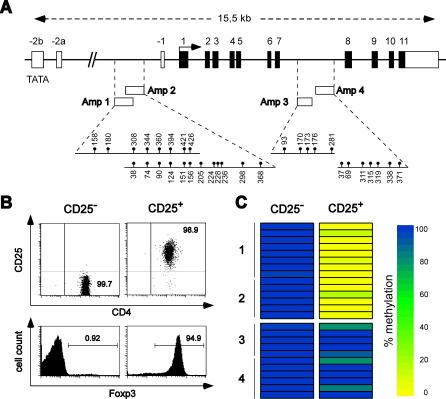
Selectively Demethylated CpG Motifs within the foxp3 Locus in CD25+CD4+ Tregs Isolated from Secondary Lymphoid Organs(A) Schematic view on the foxp3 locus depicts exon-intron structure and position of selected amplicons (Amp 1–4). Shown is the distribution and position of individual CpG motifs within the amplicons.(B) CD25+CD4+ and CD25−CD4+ T cells were sorted from spleens and LNs pooled from 20 male BALB/c mice. FACS analysis shows the sort purity (upper panel) and Foxp3 expression in sorted subsets (lower panel). Numbers display frequency of cells within indicated populations. The bars in the lower graphs indicate the marker gate for Foxp3+ cells. The vertical and horizontal lines in the upper graphs indicate the quadrant used to identify the CD4+CD25+/− subsets.(C) Methylation pattern of selected amplicons of the foxp3 locus in CD25+CD4+ Tregs and conventional CD25−CD4+ T cells. The amplicons are subdivided by horizontal lines each representing an individual CpG motif. ESME software [47] is used for normalization and quantification of methylation signals from sequencing data by calculating ratios of T and C signals at CpG sites. Data are condensed to methylation information at CpG positions forming matrices of consecutive CpGs. The methylation status of individual CpG motifs within the four amplicons is color coded according to the degree of methylation at that site. The color code ranges from yellow (0% methylation) to blue (100% methylation) according to the color scale on the right. CpG motifs from amplicon 2 overlapping with motifs in amplicon 1 were excluded. Due to sequencing problems, the CpG motif 37 from amplicon 4 is not listed. One representative experiment out of two individual experiments is shown.